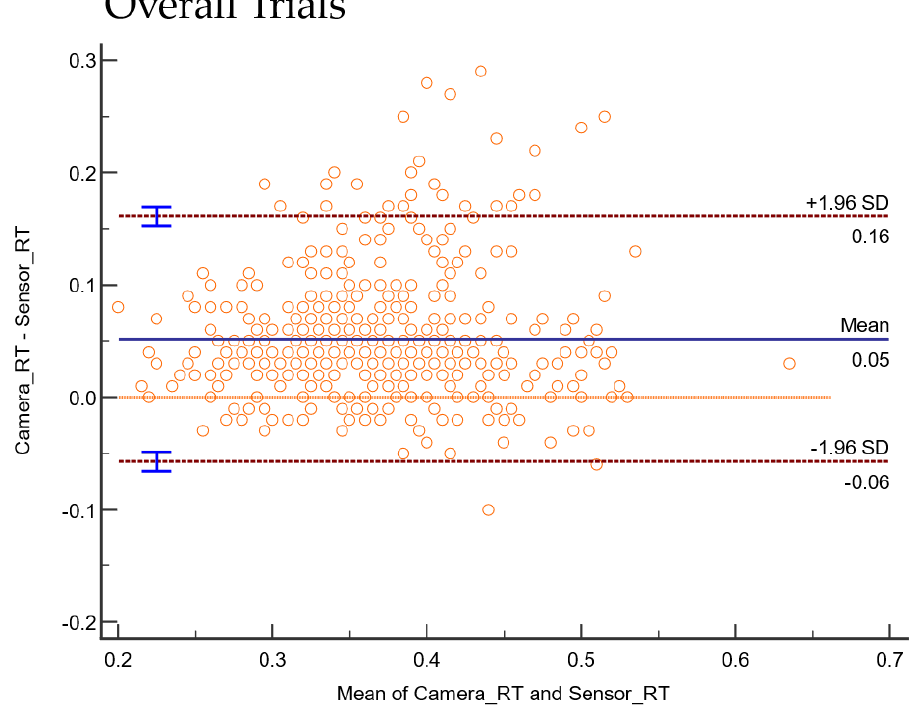
Figure 8. Plot differences between the camera and sensor systems RT versus the mean of two measurements for the overall trial with all conditions. Overall, camera systems were found to have a longer mean RT (bias) by 0.05 s.